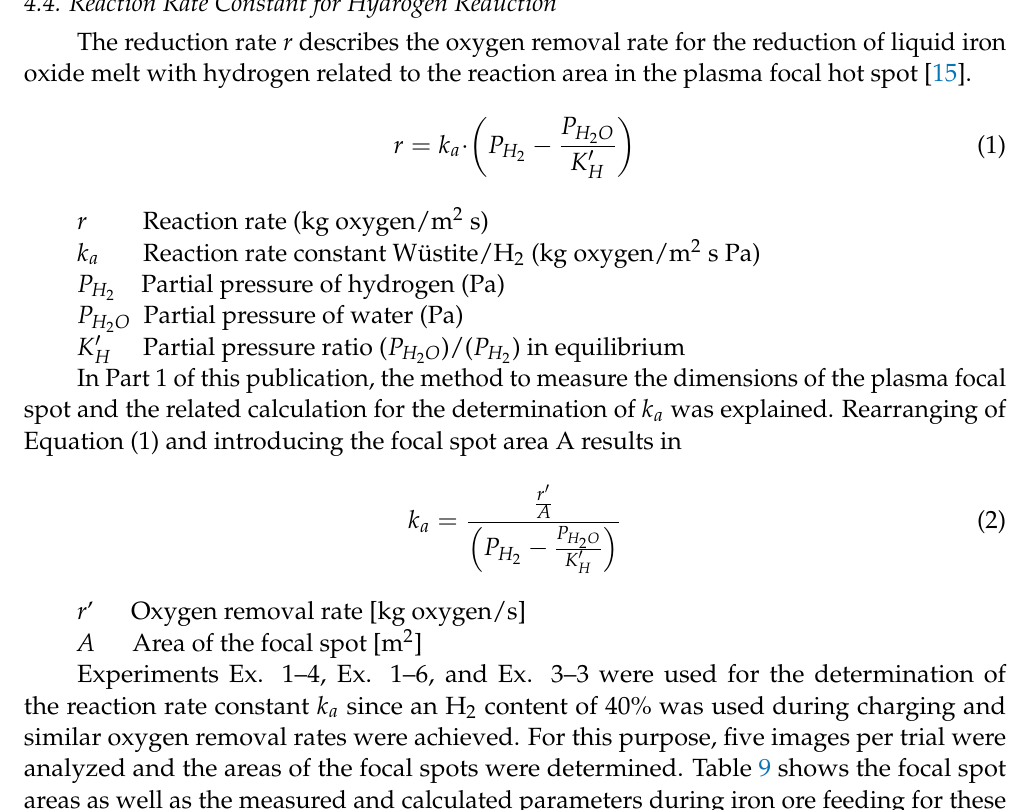
Figure 24. Oxygen removal rate in the post-reduction depending on the introduced oxygen through iron ore charging.